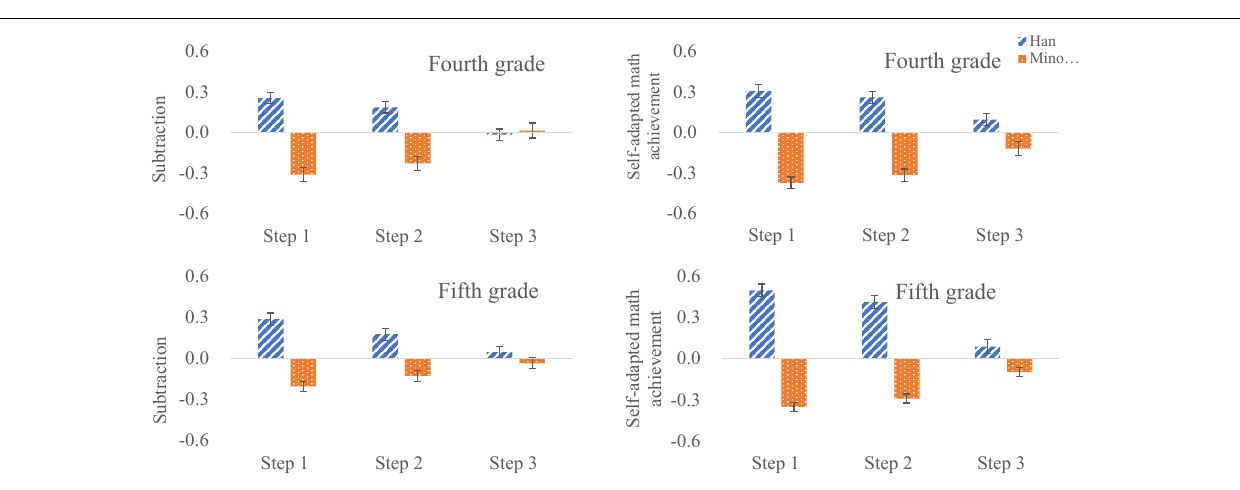
FIGURE 2 | Differences in the mean of the standardized residuals for subtraction and self-adapted math achievement between Han and minority elementary school students for fourth grade (top) and fifth grade (bottom) after controlling for age, gender (Step 1), choice reaction time, non-verbal matrix reasoning, and mental rotation (Step 2), sentence completion, and self-adapted reading comprehension (Step